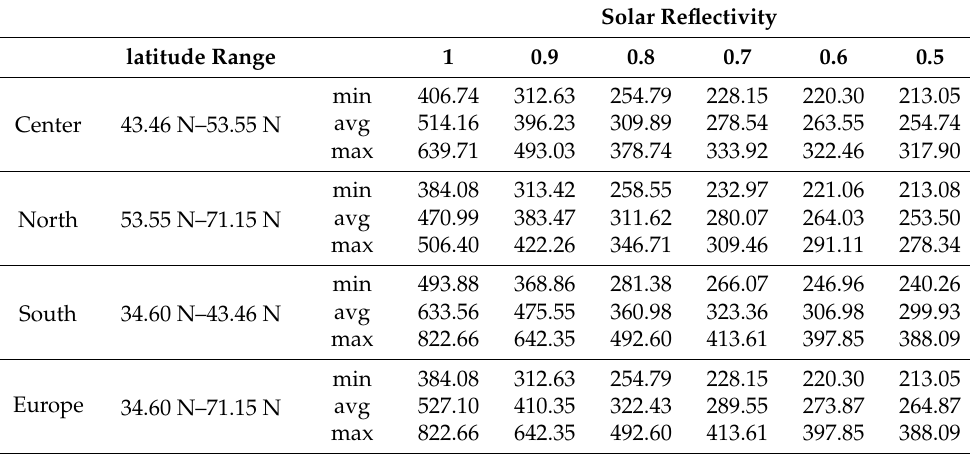
Table 8. Minimum, average and maximum values for each solar reflectivity. Potential maps of annual RC energy (kWh/m 2 · year).